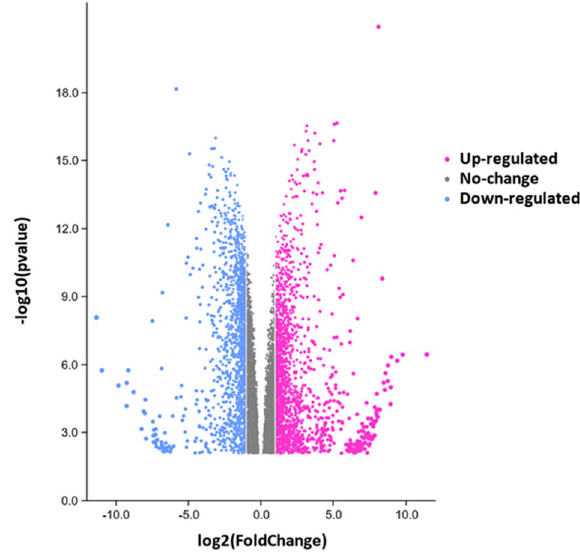
Figure 1. Volcano-plot showing significantly different differentially expressed genes in tomato plants treated with AN-SWE. Genes were considered significantly up-regulated or down-regulated if the corresponding transcript had a log FC of ≥ + 2 and ≤ − 2 respectively and a corrected p-value and FDR of <